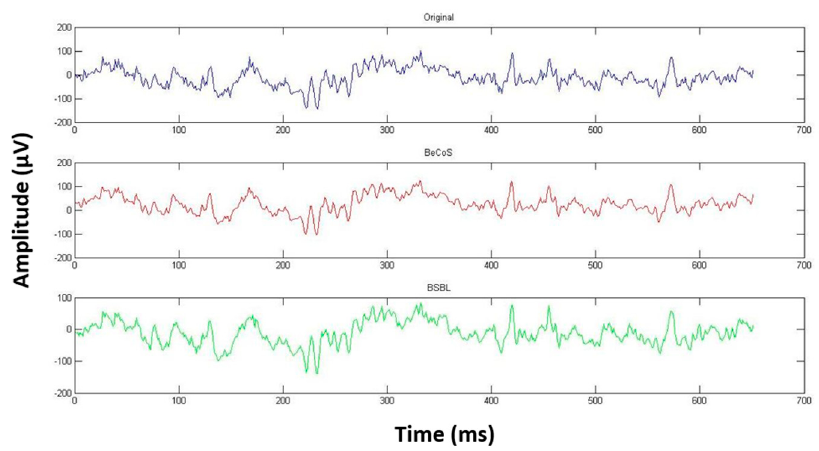
Figure 10. CW-SSIM for Channel 1 [3000:3650].